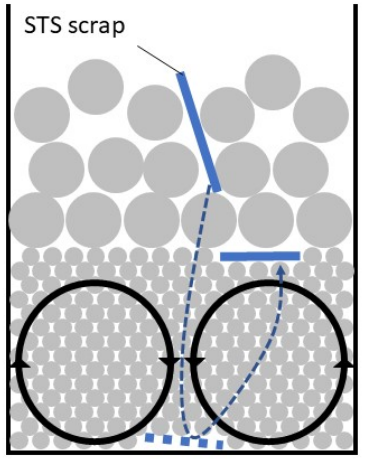
Figure 8. Schematic diagram of ball vibration in the mixed ball bed.